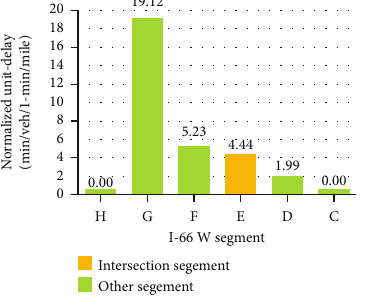
100Event: Figure 12: Normalized unit-delays of impacted segments in Case Study